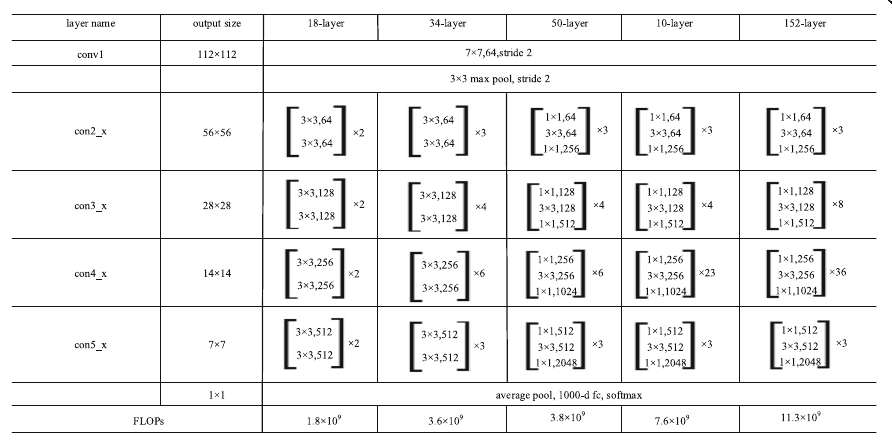
Fig. 5 Network configuration parameters of